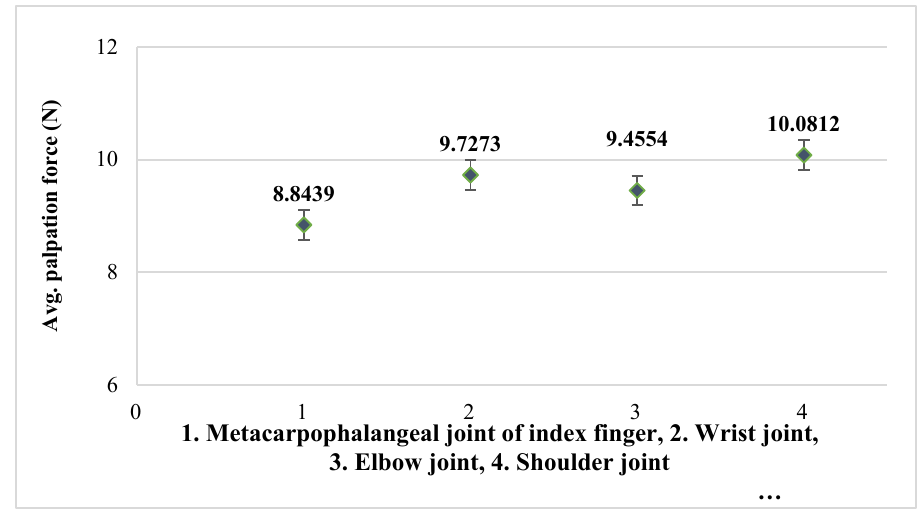
Figure 10. Average palpation force of four pivot joints (mean ± standard error).